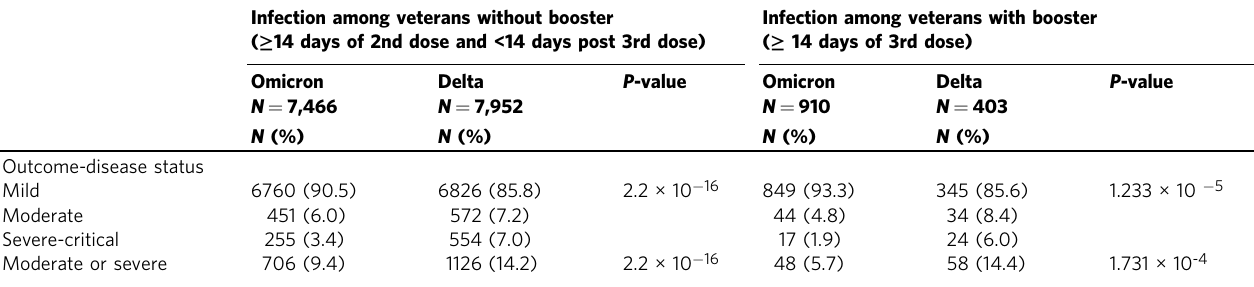
Table 3 Summary of disease outcomes of the two SARS-CoV-2 variant groups strati fi ed by vaccination status. Infection among veterans without booster ( ≥ 14 days of 2nd dose and <14 days post 3rd